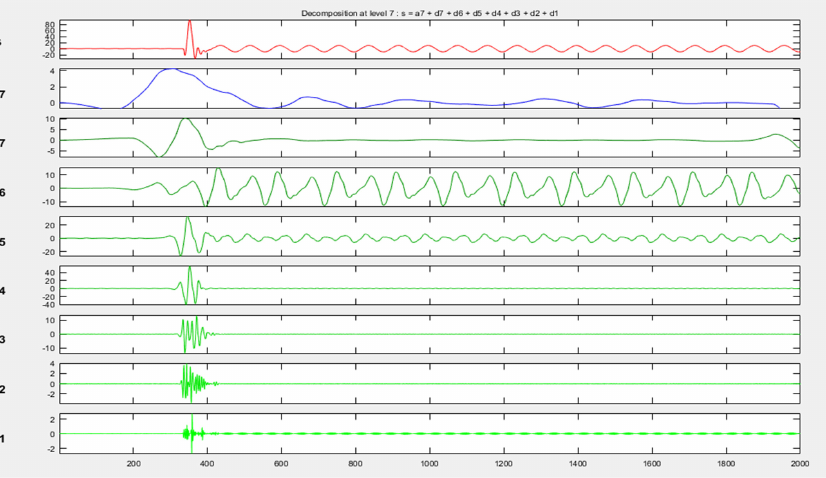
Figure 8. Representation of DWT approximation coefficients and detail coefficients of a faulty signal rotor bar fault in Phase-A currents with 2000 samples. Designation of Frequency Band